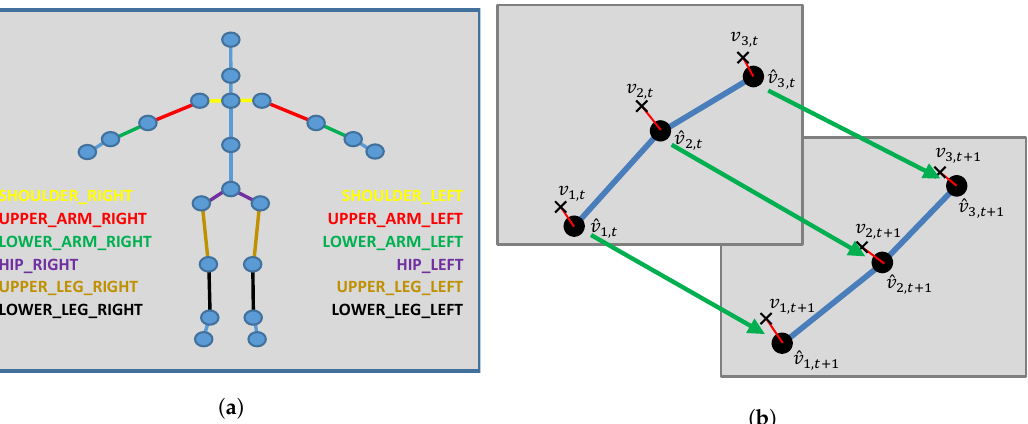
Figure 6. Left: An illustration of the used symmetry constraints. Right: An exemplary illustration of the bone length constancy constraint. ( a ) An illustration of the used symmetry constraints: Shared bone lengths are indicated by the edge colors; ( b ) An exemplary illustration of the bone length constancy constraints: While the joints move from one to the next frame, the bone lengths remain